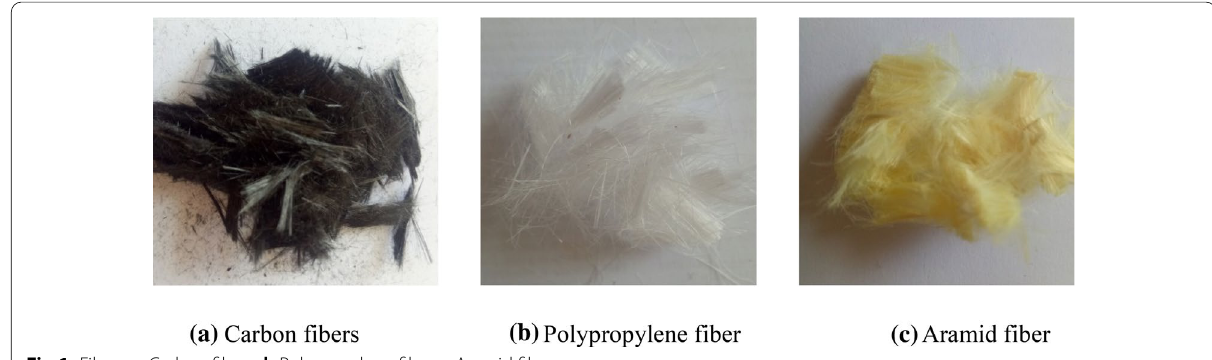
Fig.1 Fibers. a Carbon fibers. b Polypropylene fiber. c Aramid